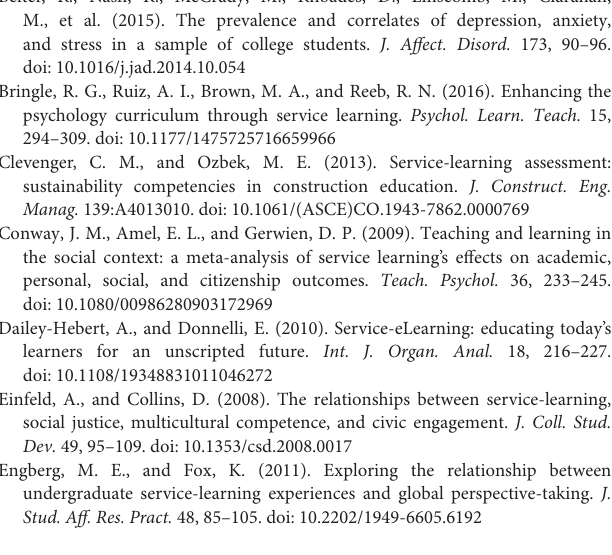
Figuccio, M. J. (2020). Comparing the effectiveness of service-learning in lower- & upper-division psychology courses. SUNY J. Scholarship Engag. 1:3. Available online at: https://digitalcommons.cortland.edu/jose/vol1/iss2/3/ Hurd, S. (2007). Anxiety and non-anxiety in a distance